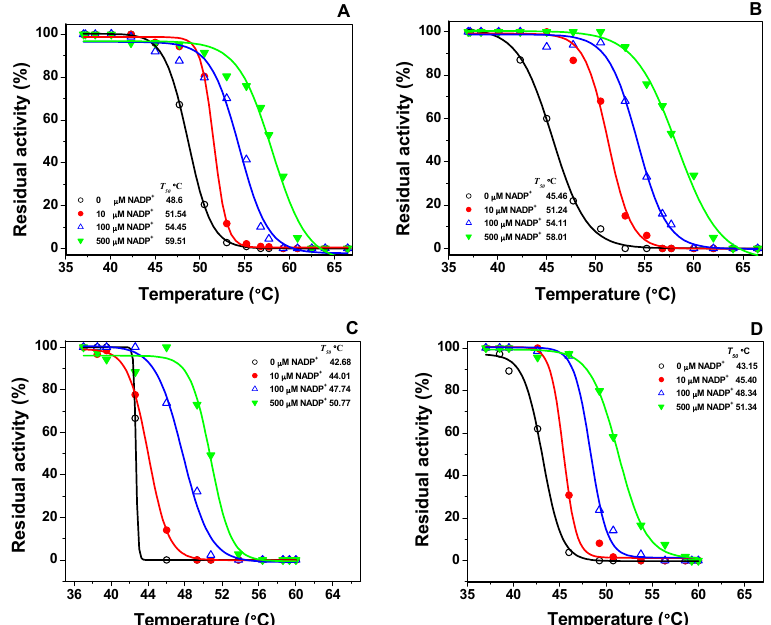
Figure 5. Thermal inactivation assays of recombinant G6PD variants in the presence and absence of different concentrations of NADP + . ( A ) WT G6PD; ( B ) G6PD A+; ( C ) G6PD Nefza; ( D ) G6PD A − . In all cases, 200 ng of total protein was used. Residual activity was expressed as a percentage of the activity for the same sample incubated at 37 °C. The assays were performed in triplicate; standard errors were lower than 5%.